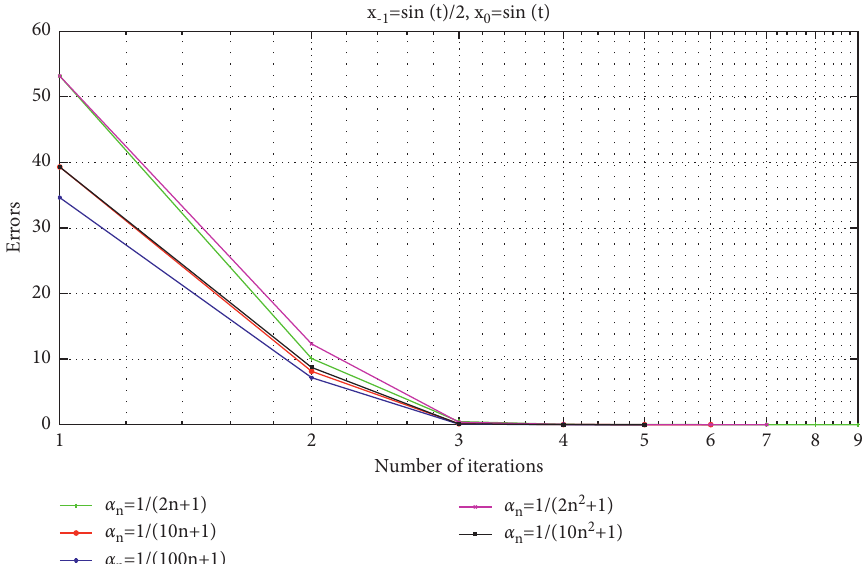
Figure 7: The Cauchy error plotting number of iterations for different parameters α